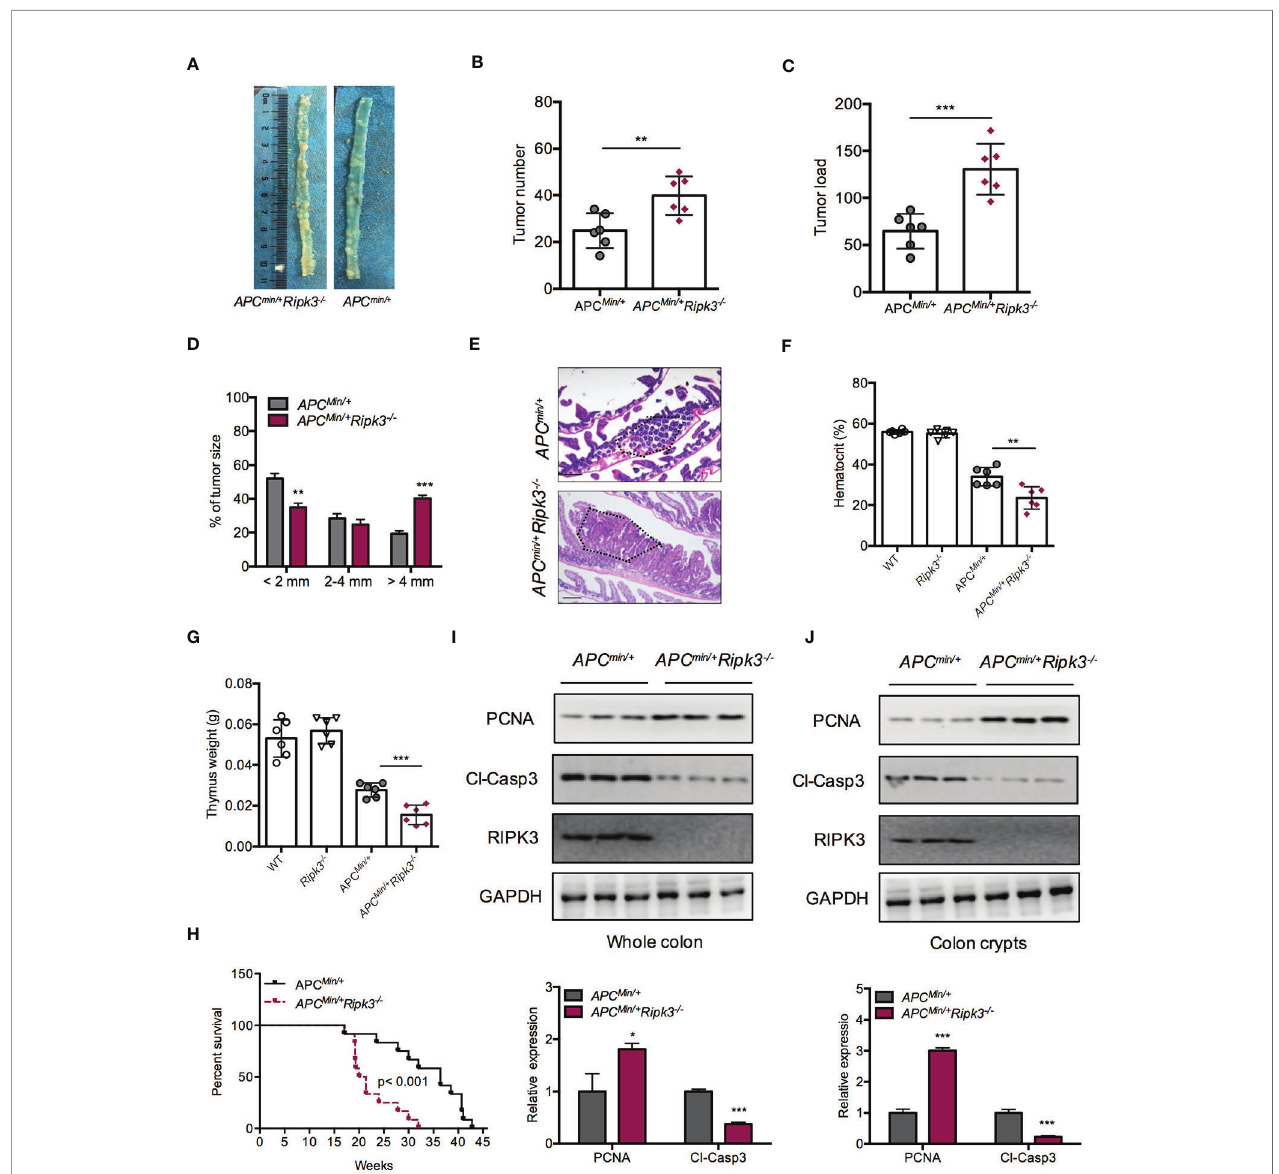
FIGURE 2 | Loss of RIPK3 aggravates tumor burden in Apc Min/+ mice. (A) Polyps in representative intestines from Apc min/+ and Apc min/+ Ripk3 -/- mice. (B, C) Number of polyps formed (B) and tumor load (C) in 16-week-old Apc min/+ and Apc min/+ Ripk3 -/- intestines. (D) Distribution of tumor size in 16-week-old Apc min/+ and Apc min/+ Ripk3 -/- mice. (E) Images of the H&E-stained intestines from Apc min/+ and Apc min/+ Ripk3 -/- mice. (F, G) Hematocrit (F) and thymus weight (G) of 16-week- old WT, Ripk3 -/- , Apc min/+ and Apc min/+ Ripk3 -/- mice. (H) Survival of Apc min/+ and Apc min/+ Ripk3 -/- mice as indicated. * p < 0.05, ** p < 0.01 and *** p < 0.001 versus Apc min/+ mice. (I, J) Whole intestines and colonic crypts were isolated from 16-week-old Apc min/+ and Apc min/+ Ripk3 -/- mice. PCNA and cleavage of caspase-3 were analyzed by western blotting. * p < 0.05 and *** p < 0.001 versus Apc min/+